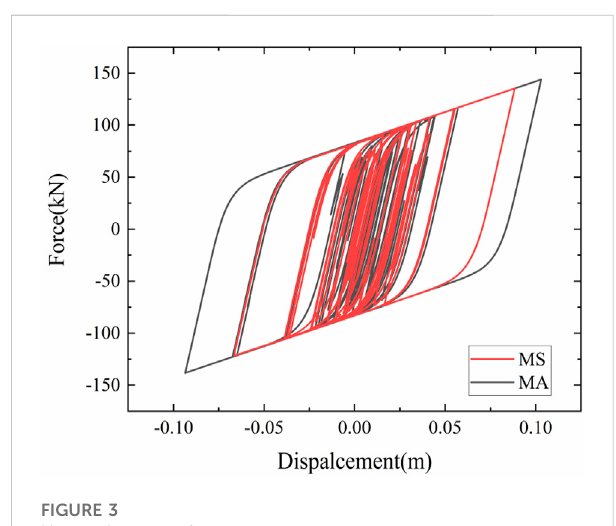
FIGURE 3 Hysteretic curve of